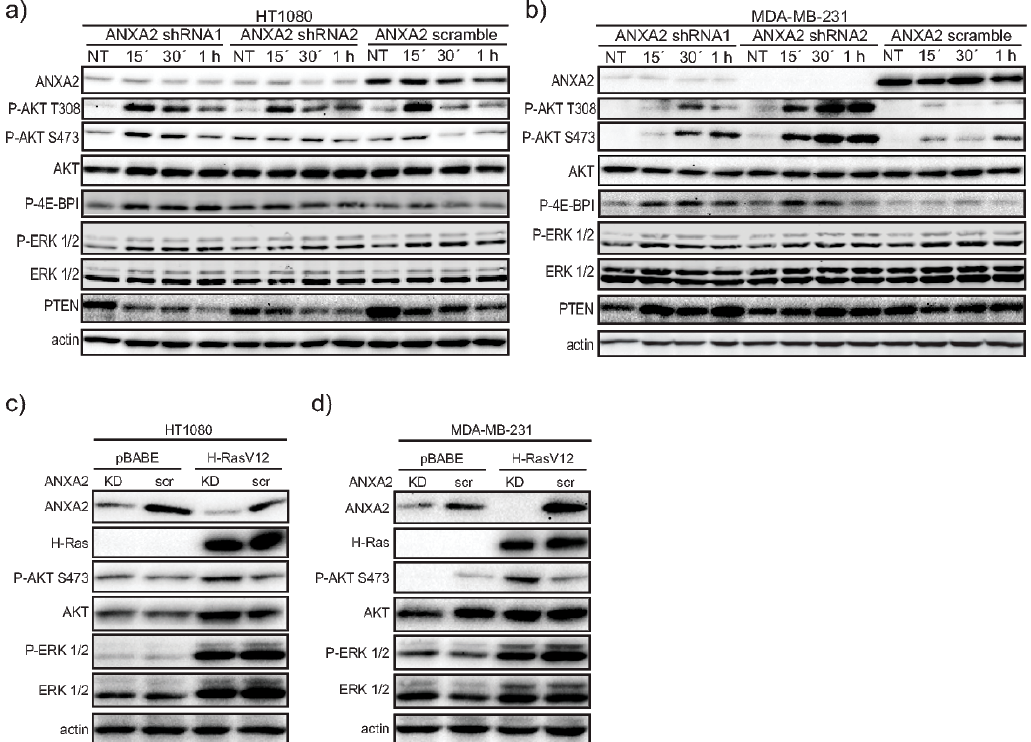
Figure 1. ANXA2 depleted cancer cells show enhanced AKT phosphorylation/activation upon H 2 O 2 dependent signaling compared to control cells. ( a ) HT1080 or ( b ) MDA-MB-231 cancer cells depleted of ANXA2 (ANXA2 shRNA1, ANXA2 shRNA2) or controls (ANXA2 scramble) were serum starved for 6 h (HT1080) or for 16 h (MDA-MB-231) and either not treated (NT) or treated with 15 nM EGF for the times indicated. ( c ) HT1080 or ( d ) MDA-MB-231 ANXA2 knockdown (KD) and control (scr) cells expressing H-RasV12 or the empty vector pBABE were grown in serum free media for 6 h or 16 h, respectively, after what cells were lysed and 20 µ g of each protein extract was subjected to SDS-PAGE, transferred onto nitrocellulose membranes and analyzed by western blotting with the antibodies indicated. Results are representative of at least three independent experiments ( n ≥ 3).